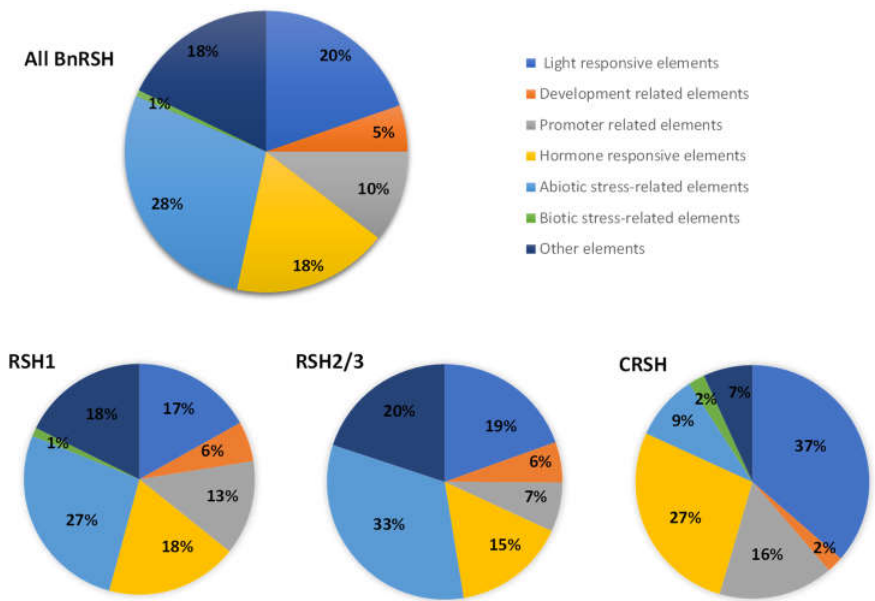
Figure 6. Frequencies of putative cis -regulatory elements in B. napus RSH genes (upper pie chart), and in BnRSH1 , BnRSH2/3 , and CRSH genes (lower pie charts). Pie charts depict the cis -regulatory elements categorized in seven types according to their predicted functions.